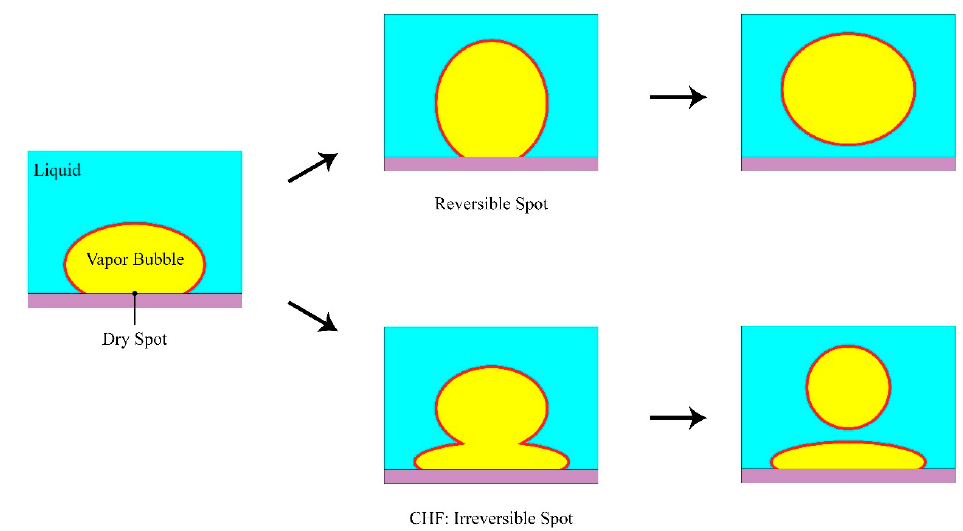
Figure 15. Schematic of a CHF model according to the theory of irreversible dry spot. Adapted from Liang and Mudawar. Reproduced from [252], Elsevier: 2018.